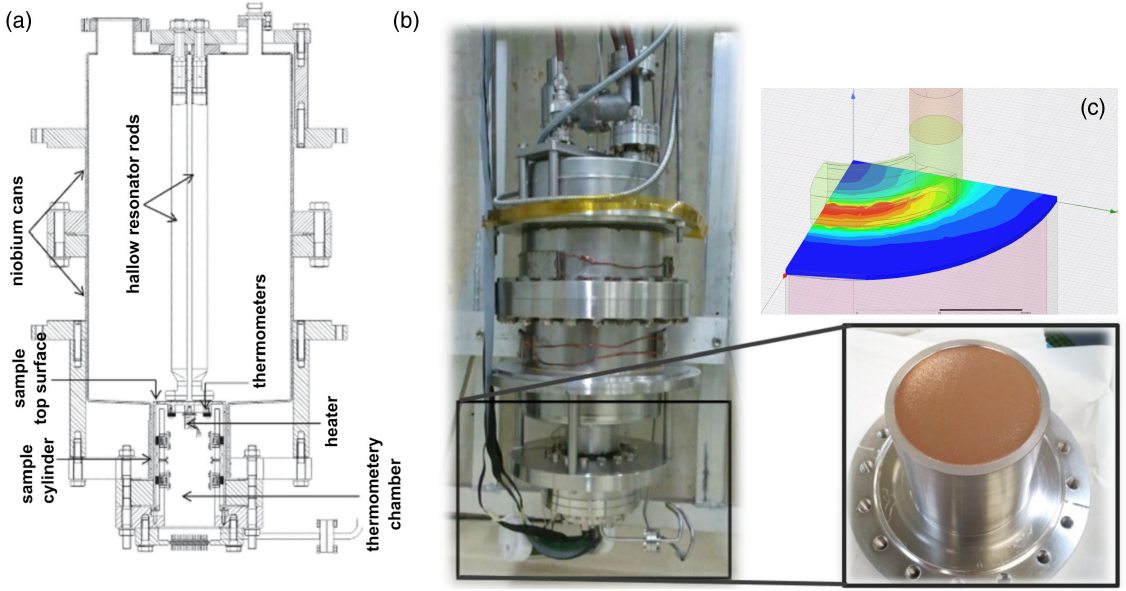
FIG. 1. The quadrupole resonator at CERN. (a) Schematic cross-section drawing, indicating the main parts: resonator rods, thermometers, heater, sample parts, and cavity cans [18]. (b) Photo of the quadrupole resonator at CERN and of a bare copper sample. (c) rf magnetic field pattern on a quarter of the sample surface for the 400 MHz quadrupole mode from numerical simulations. Red corresponds to the highest field, and blue to the